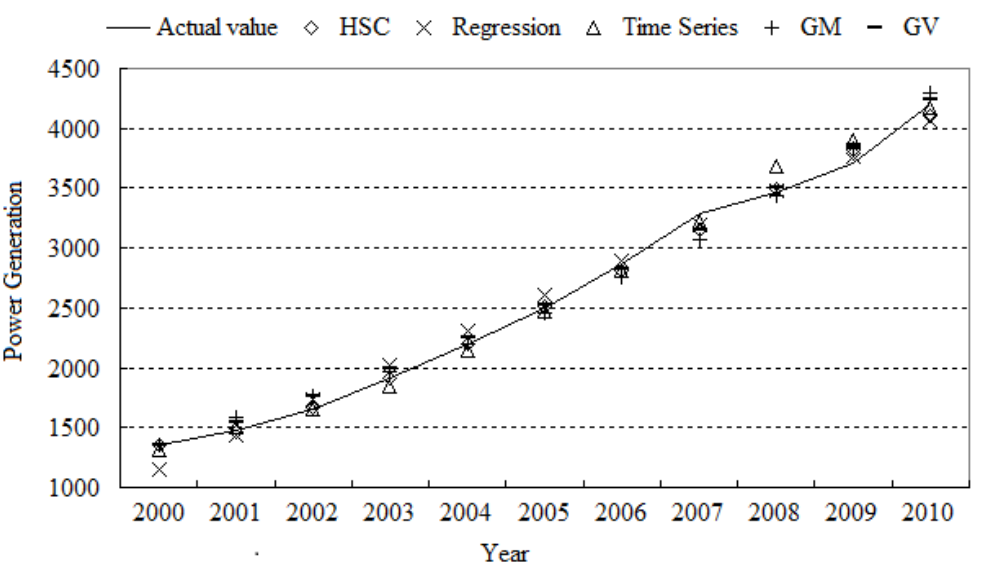
Figure 2. Forecasting performance of HS based JPOC model and other four single models for